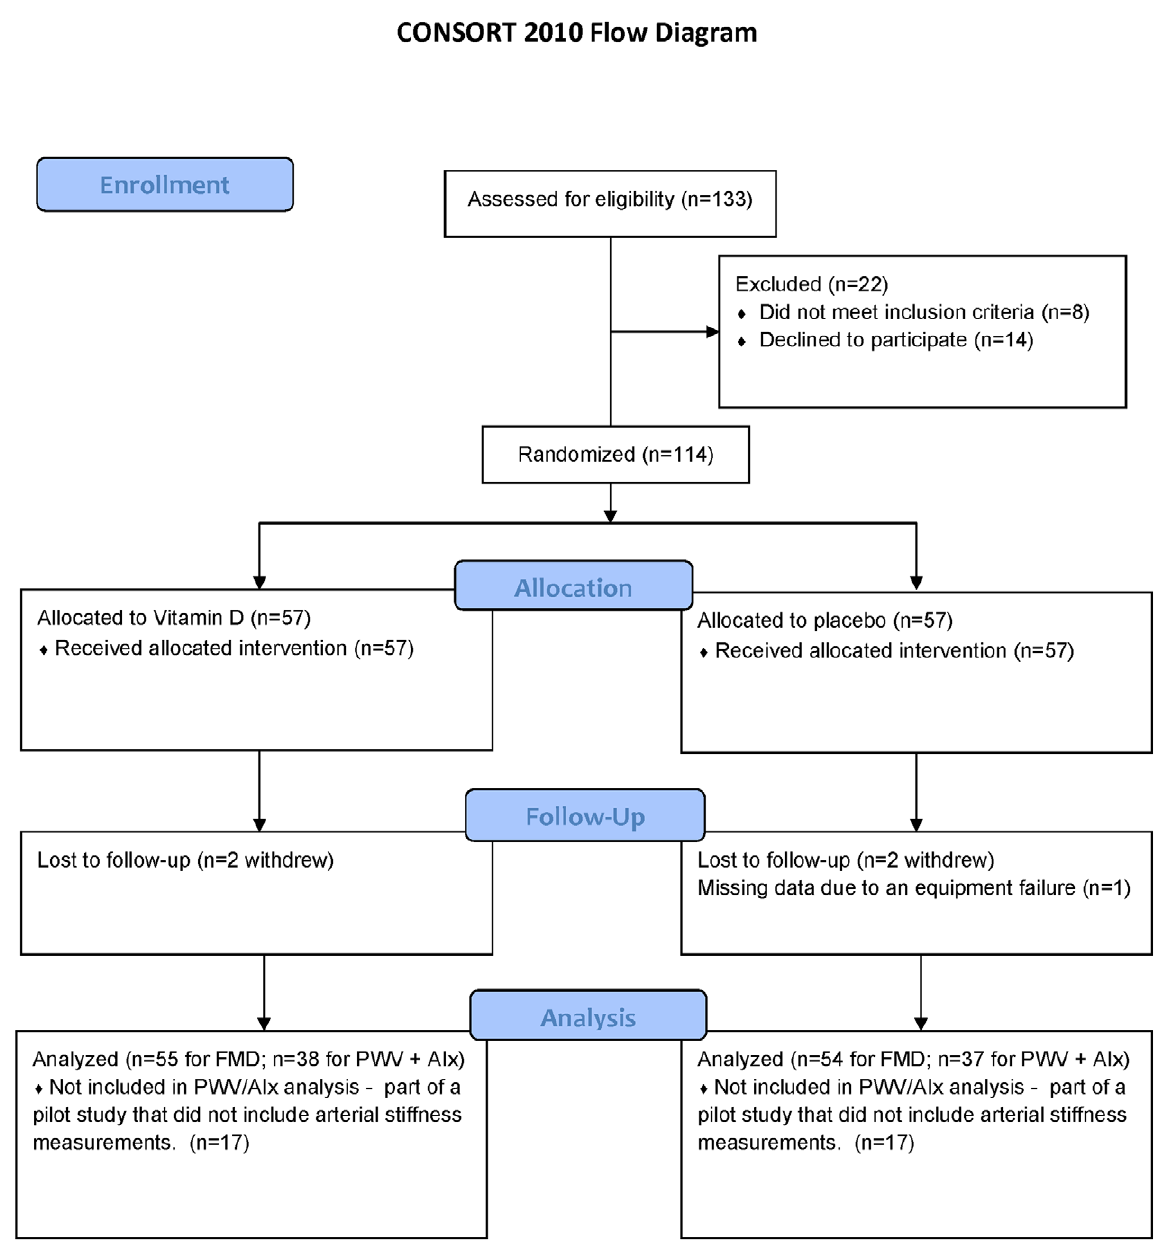
Figure 1. CONSORT 2010 Flow Diagram. The first 34 subjects were part of a pilot study performed under NCT 00690417. The remainder of the subjects were performed under NCT